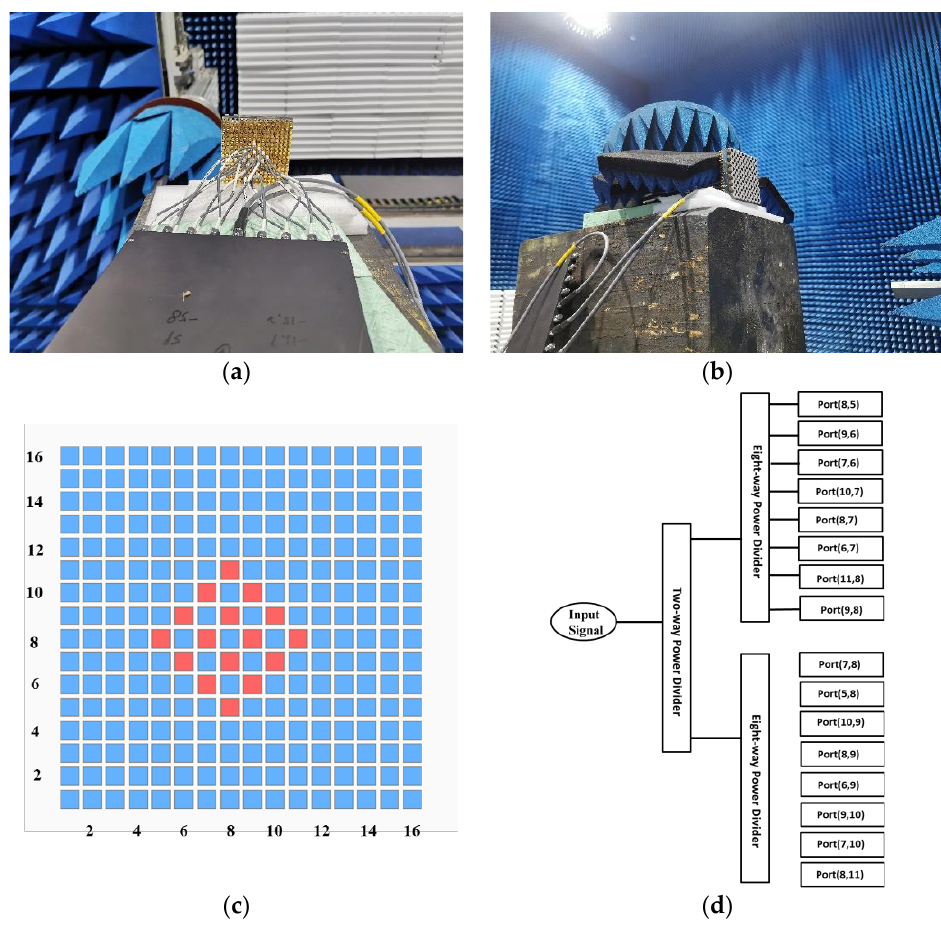
Figure 9. Pattern measurement of central 4 × 4 subarray of the proposed array ( a ) PUMA array in an anechoic chamber during PNT ( b ) PUMA array with power dividers and absorber materials ( c ) excitation indication in a 256-port array ( d ) schematic diagram of the subarray pattern measurement.